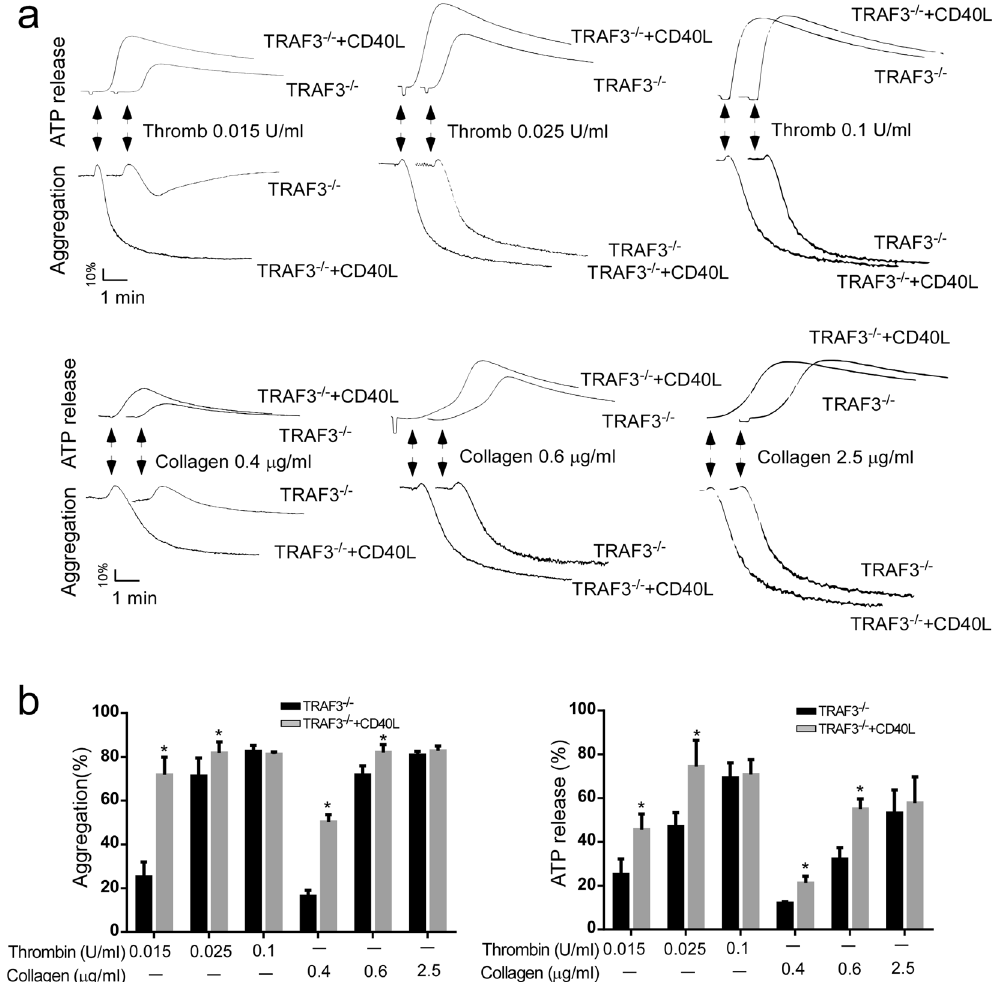
Figure 5. CD40L potentiates platelet aggregation and secretion in TRAF3 − / − mice. ( a and b ) Washed platelets (3 × 10 8 /ml) from TRAF3 + / + mice were exposed to thrombin or collagen in the presence or absence of CD40L to induce platelet aggregation and ATP release. The aggregation and ATP release traces are representatives of at least three different experiments. Aggregation and ATP secretion results in the experiments described in ( a ) were quantitated and shown in ( b ) (n = 3, * p <